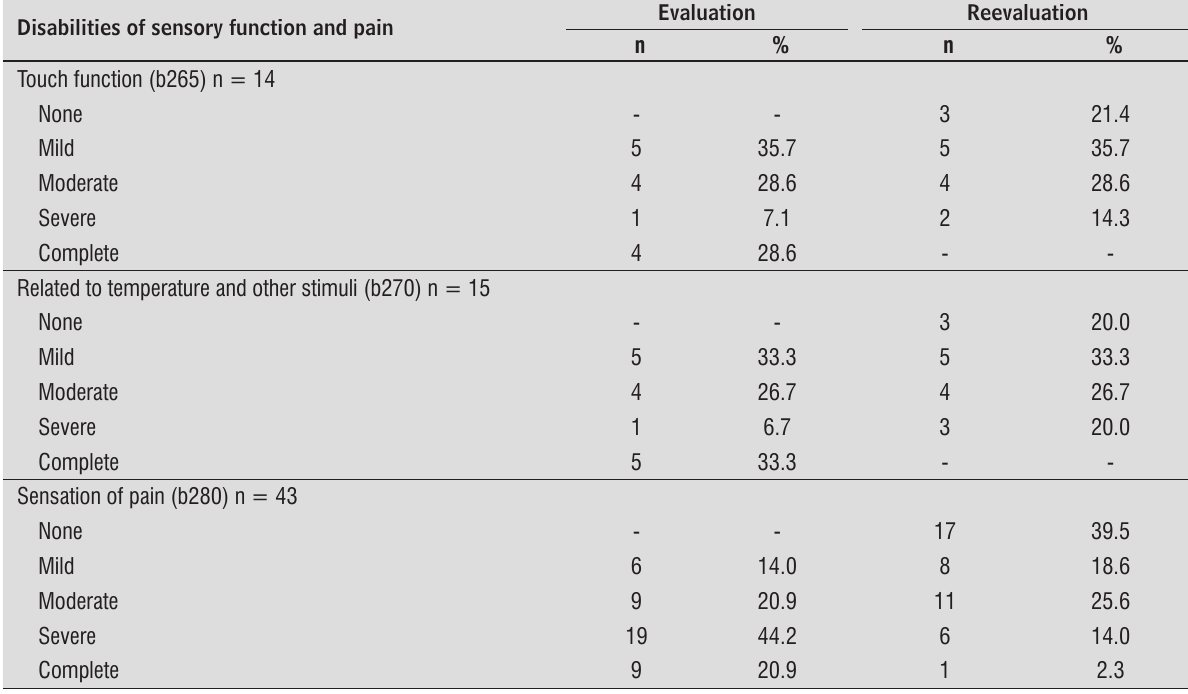
Table 2 - Distribution of the degree of disability related to sensory function and pain in victims of traffic accidents on evaluation and reevaluation. Cuiabá/MT, 2010 Disabilities of sensory function and pain